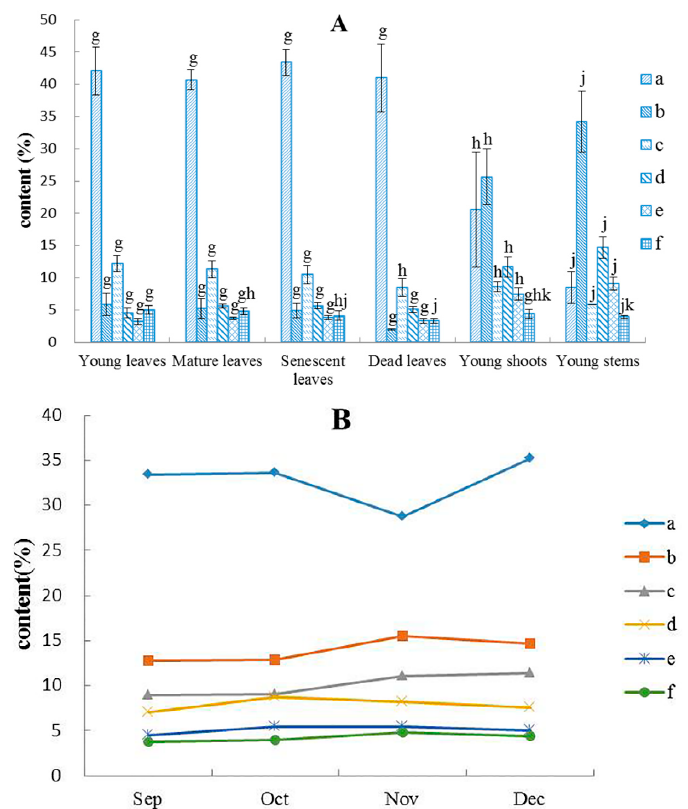
Figure 1. Variation in major chemical constituents in different plant organs ( A ) and months ( B